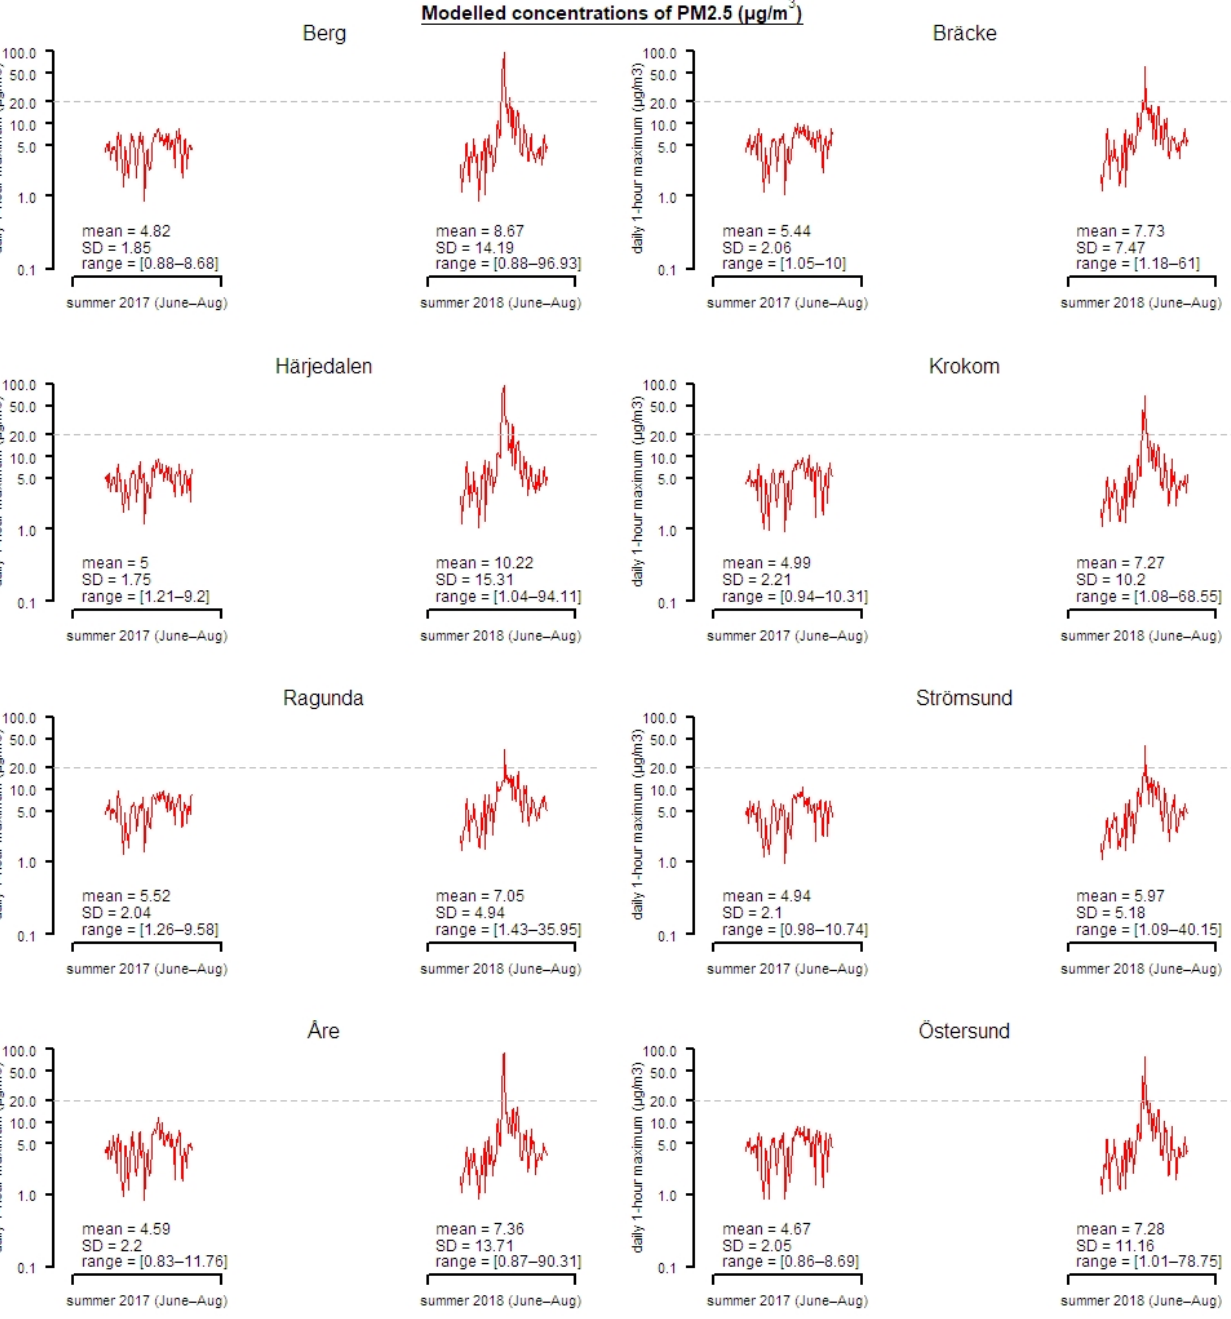
Figure 2. Modelled population-weighted concentrations of PM 2.5 (daily maximum 1-h mean values) for the municipalities in region Jämtland Härjedalen June to August 2017 and 2018. Y -axis are on a log scale, and for each municipality, the total mean value (mean), standard deviation (SD) and minimum and maximum values (range) are printed.